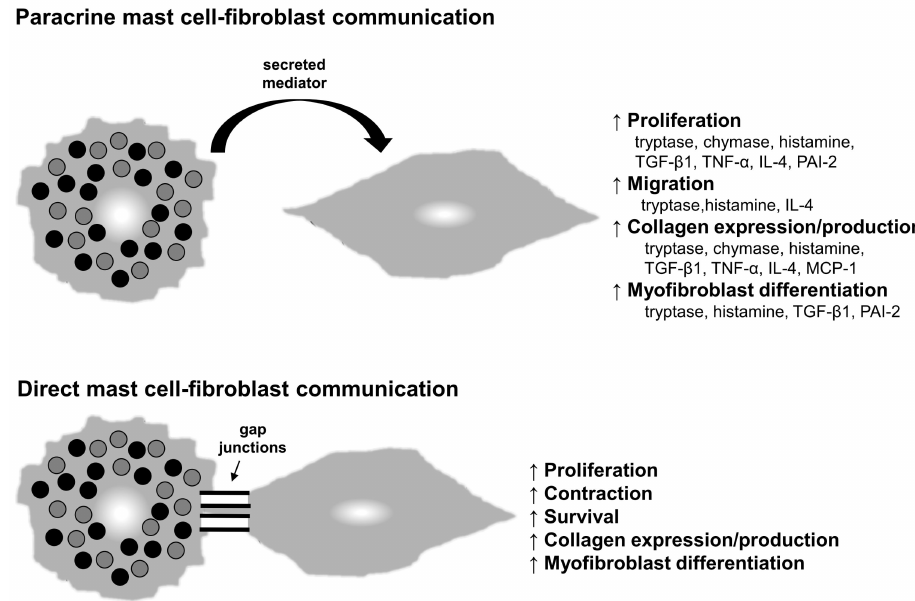
Figure 2. Mast cell–fibroblast interactions. Mast cells can influence the behavior of fibroblasts by secreting mediators that act in a paracrine manner ( top ) or by directly interacting with fibroblasts through heterocellular gap junctions ( bottom